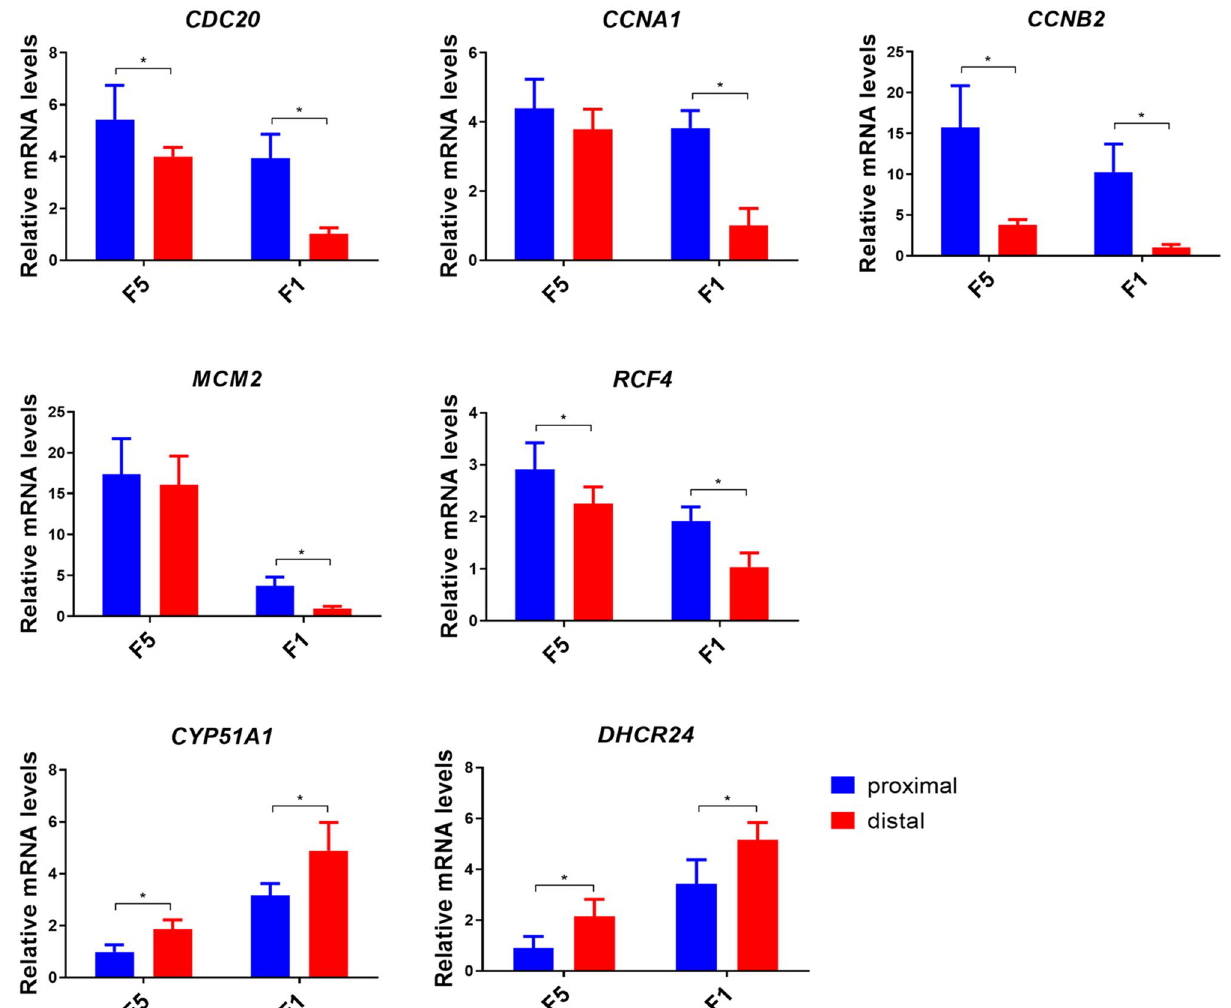
mean of ten individuals (N = 10) * p <